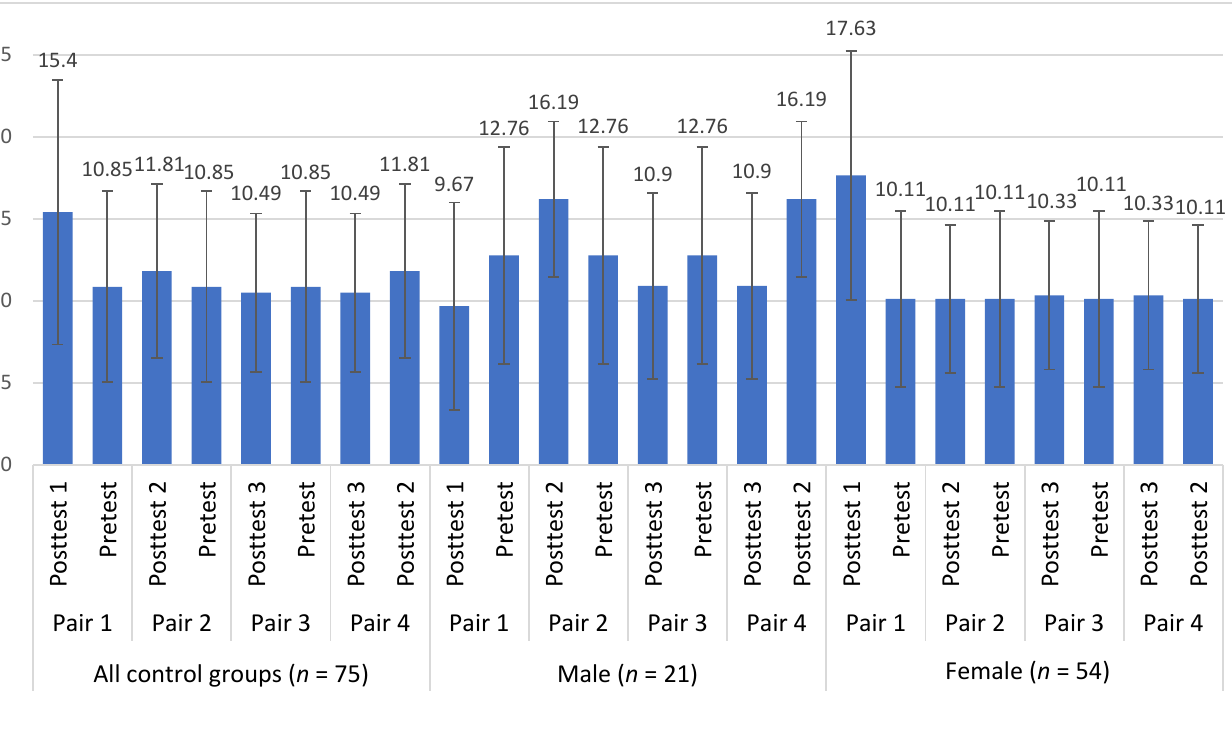
Table 4. Paired Samples t-test Results for the Differences Between Paired Tests Within the Experi- mental Groups.